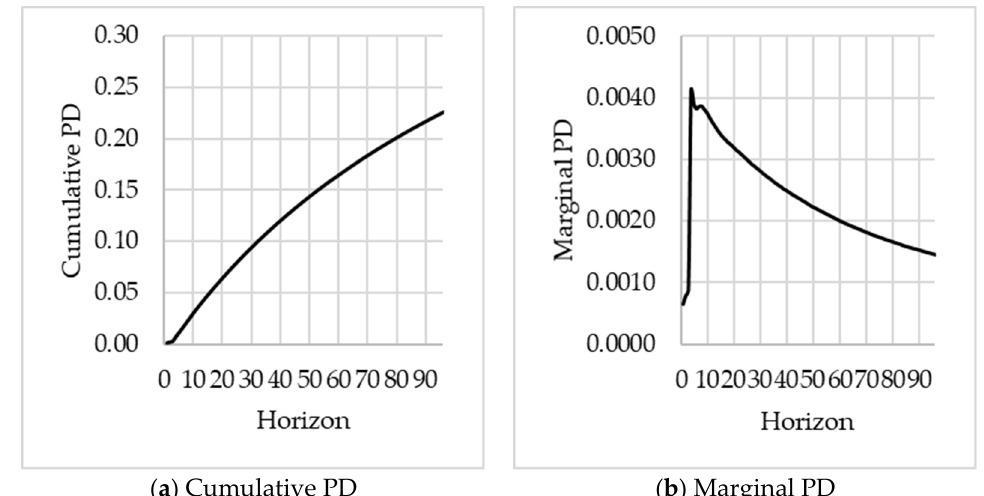
Figure 2. Cumulative and Marginal PD term